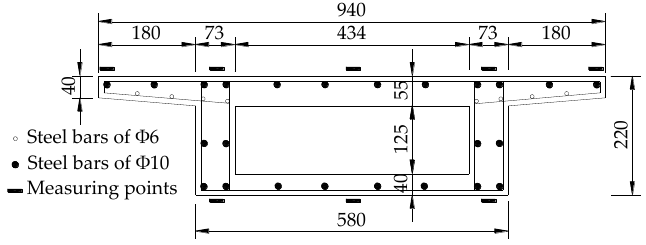
Figure 1. Layout plan of the IACBG bridge model (unit: mm).